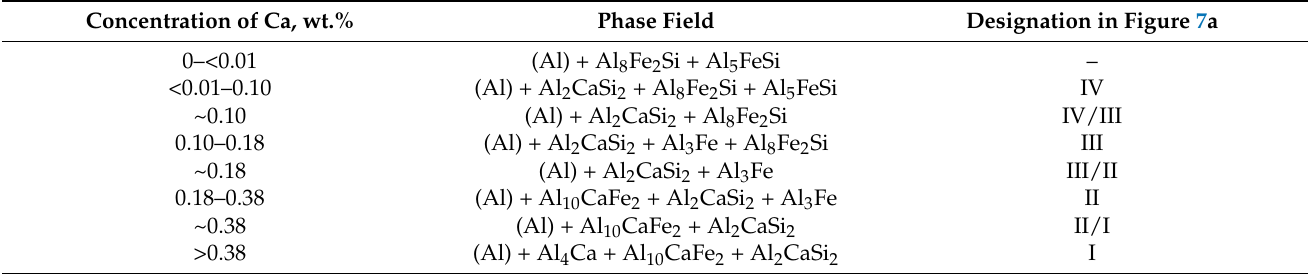
Table 4. Effect of Ca concentration on phase composition of alloy Al-0.5% Fe-0.25% Si (calculated at 200 ◦ C). Concentration of Ca, wt.%